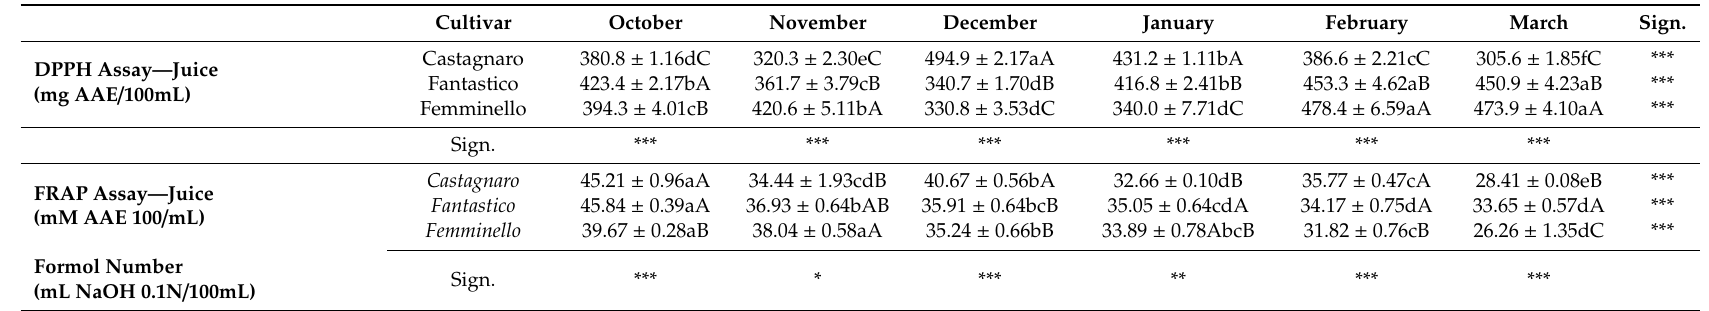
Table 8. Antioxidant activity of bergamot juice. AAE = ascorbic acid equivalent. Results are presented as the mean value ± standard deviation, n = 8, (2016–2017 and 2017–2018 harvest years). *** significance at p < 0.001; ** significance at p < 0.01; * significance at p < 0.05. Means in the same line are distinguished by small letters. Means in the same column are distinguished by capital